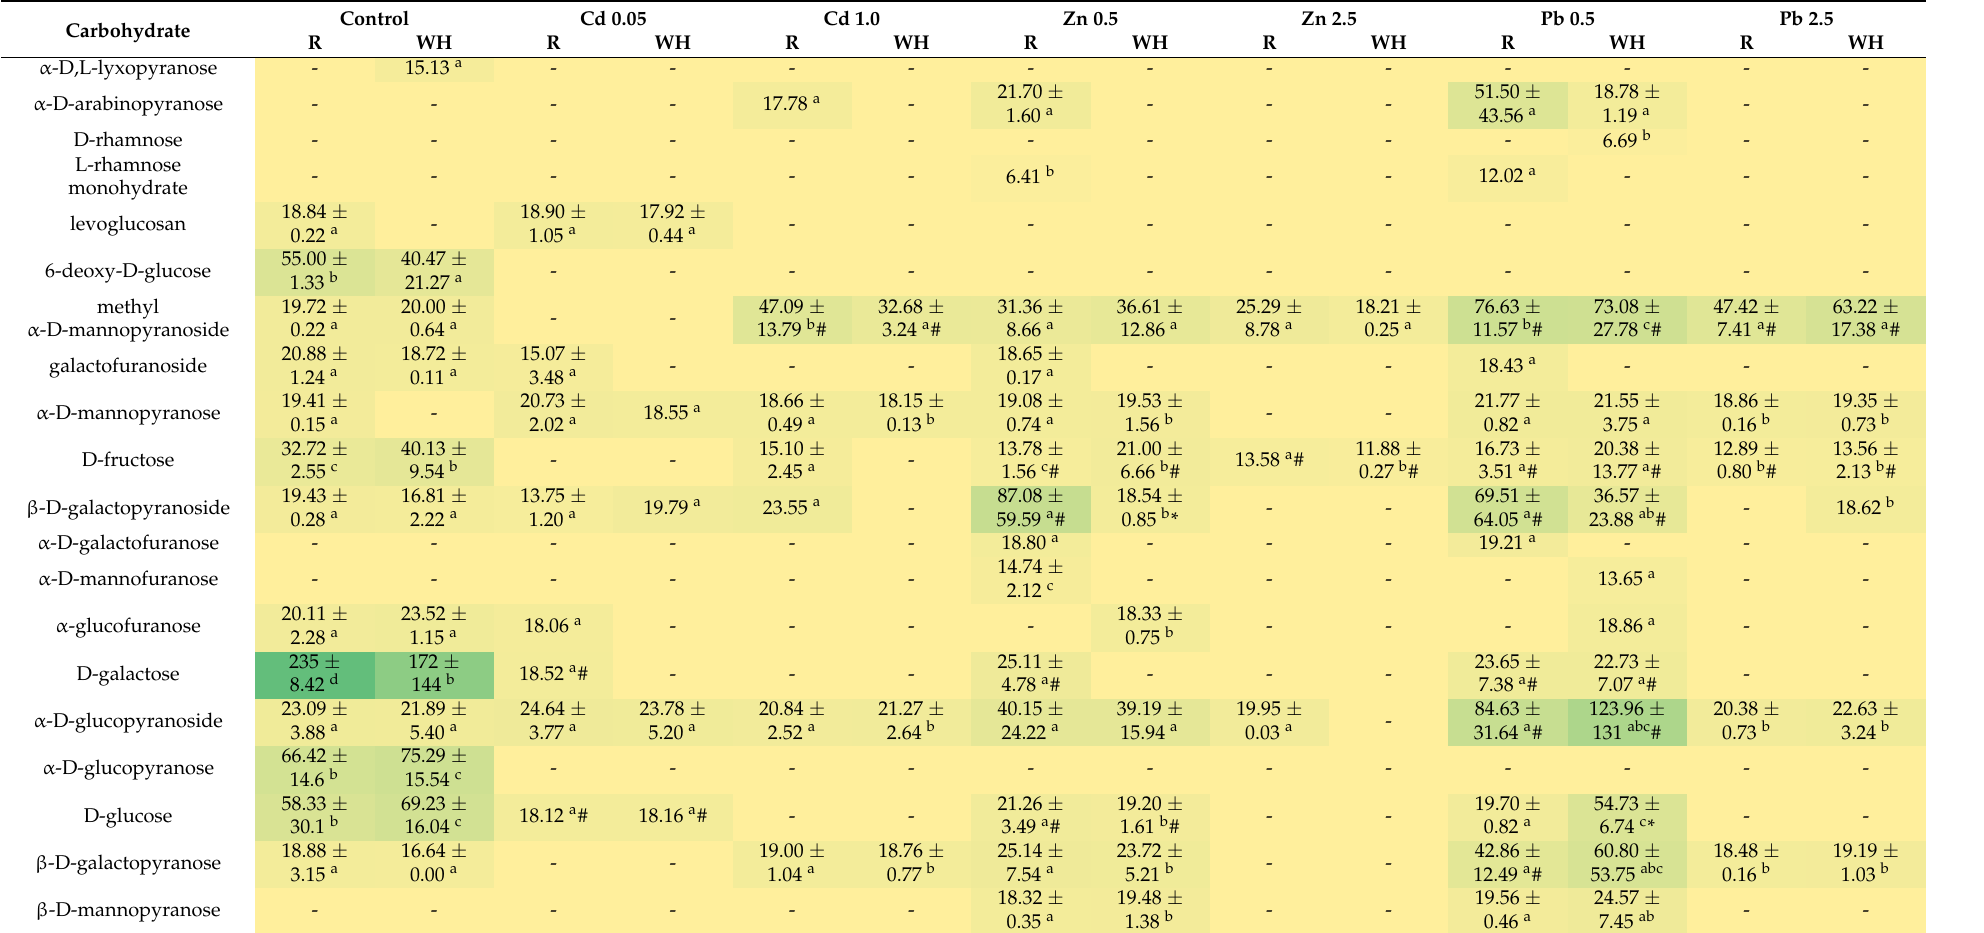
Table 1. Qualitative and quantitative ( µ g µ L − 1 ) carbohydrate composition of exopolysaccharide Rhizobium leguminosarum bv. trifolii strains isolated from root nodules of Trifolium repens growing on the non-polluted reference grassland in Bolestraszyce (R) and the metal-polluted waste heap in Bolesław (WH) not exposed (control) and exposed to 0.05 mM Cd (Cd 0.05) and